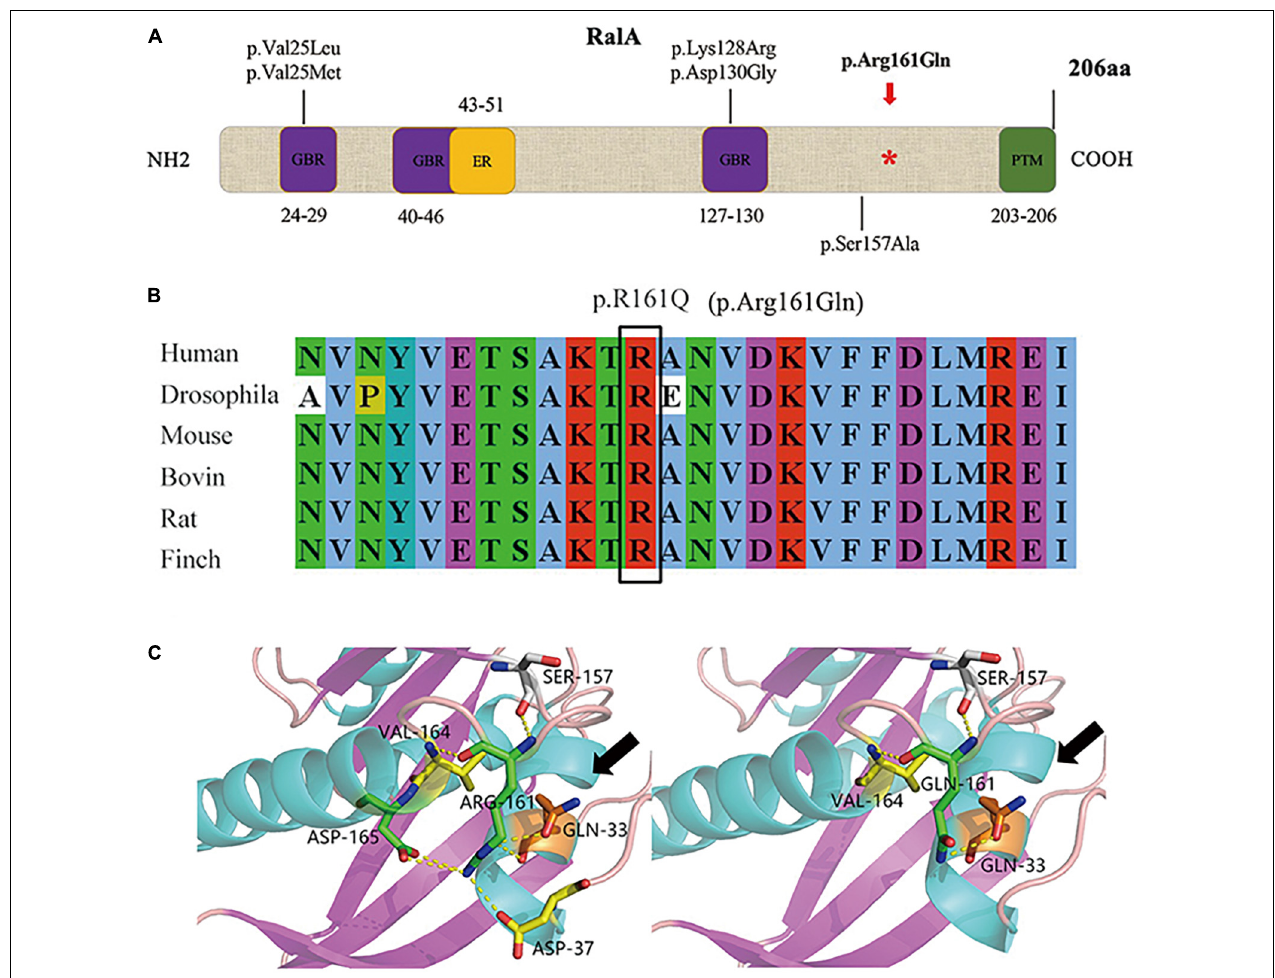
FIGURE 2 | Domain diagram of human RalA and RALA variants. (A) Domains of RalA. GBR, GTP/GDP binding regions; ER, effector region; PTM, posttranslational modification. A red asterisk *: mutation site of RALA we identified in FCD type II tissue. The other variants associated with neurological diseases are also shown. (B) Homology comparison between species of RALA variant. (C) Protein structure before and after mutation of RALA c.G482A (p.Arg161Gln), as indicated by the black arrow.